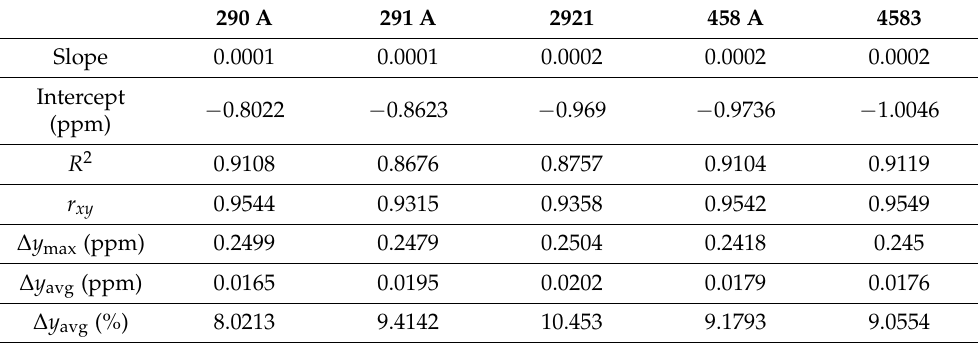
Table 9. Calculated values for data analysis of CO sensors.